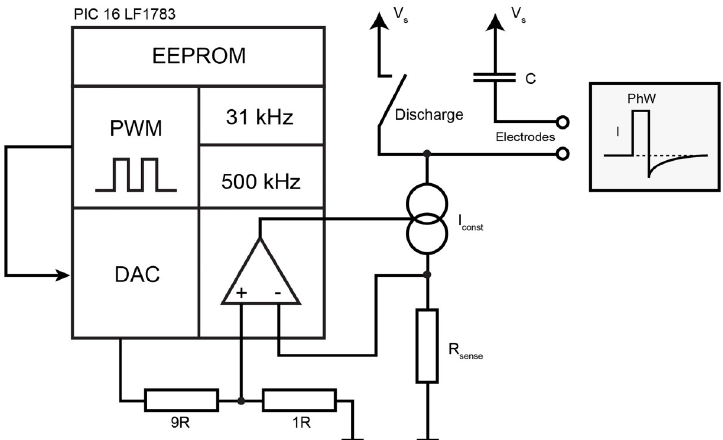
Fig 1. Functional blocks used to generate pulses. Data for the desired stimulation pattern was stored in the EEPROM of the microcontroller. The microprocessor’s pulse-width-modulation (PWM) module was used to generate digital pulses that were forwarded to the digital-to-analog-converter (DAC) module. The output of the DAC module was presented to the operational-amplifier, which controlled a bipolar transistor to realize a constant-current-source (Iconst). Current delivered to the tissue charged a capacitor (C), which allowed to generate a charge-balancing second phase by closing an additional discharge-switch after the pulse.